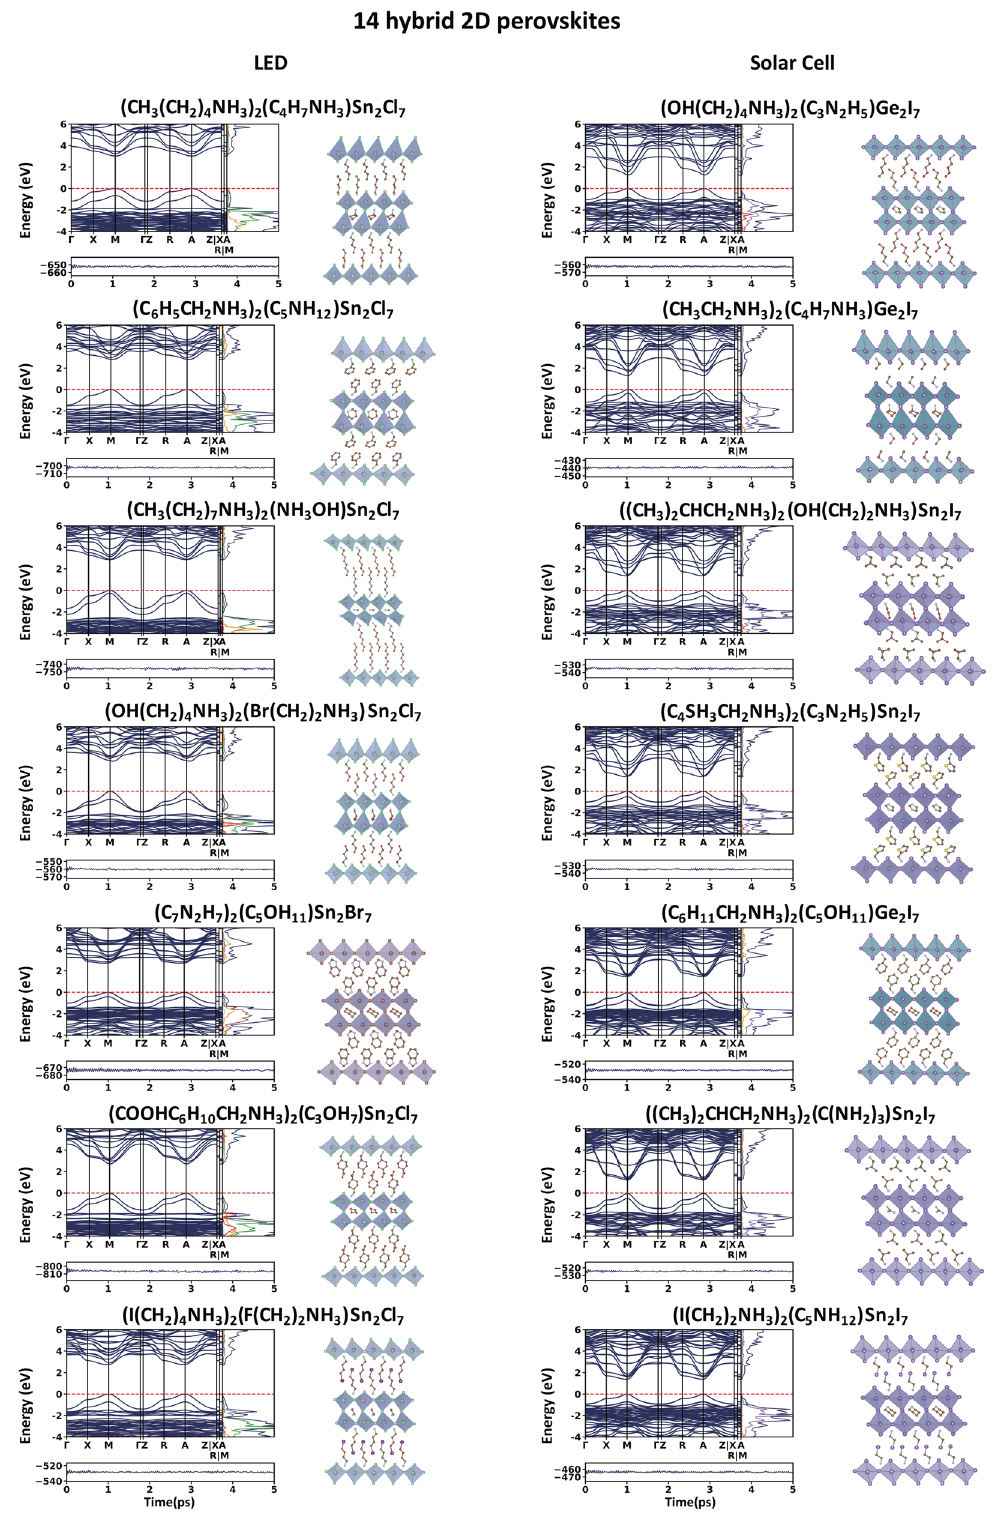
Fig. 5 Fourteen HOIPs chosen from the NSGA-II/MOBO screening results (seven for LED applications and seven for solar cell applications), including the HSE06-based band structure and DOS results; the band structure and DOS were drawn based on the original Bravais lattice. The AIMD total energy plot as a function of time for 5 ps is also presented on the